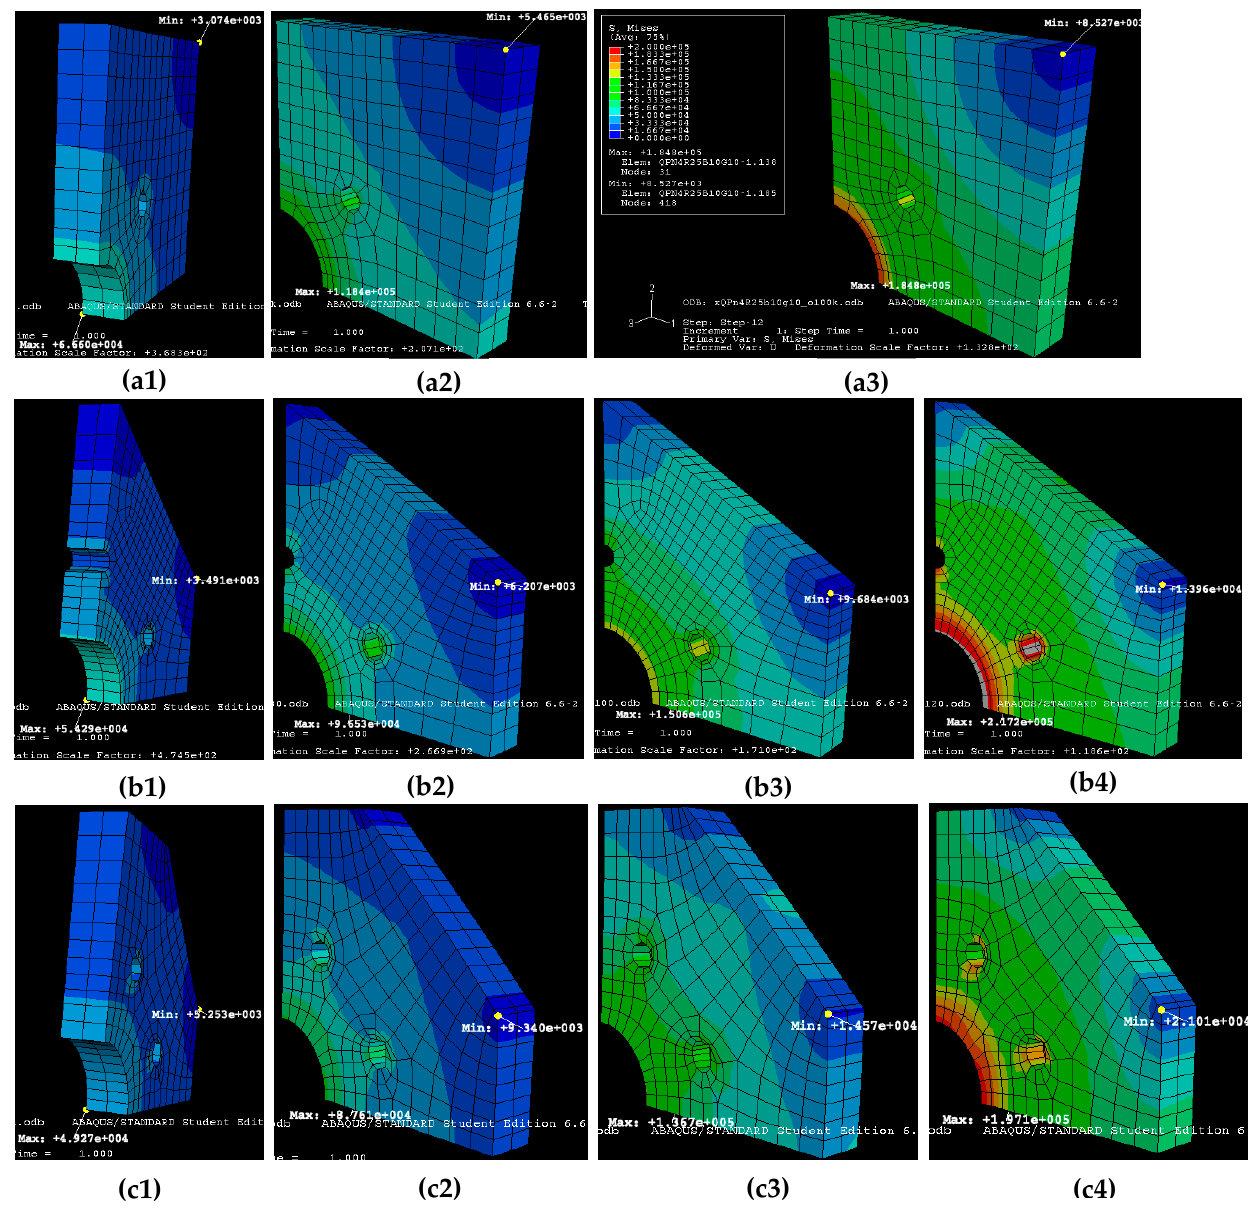
Figure 12. Extreme values of the stress ( σ max and σ min ) for rotational PMs with ( a ) n = 4, ( b ) n = 6, and ( c ) n = 8, for four levels of the rotational speed ω : ( 1 ) 60 krpm; ( 2 ) 80 krpm; ( 3 ) 100 krpm; ( 4 ) 120 krpm. The PM parameters are R = 25 mm, r = 5 mm, b = 10 mm, R h = 13 mm, and δ = 2 mm.